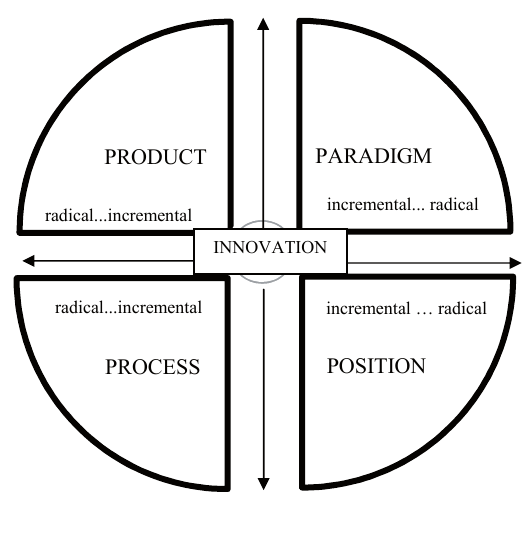
Fig. 2 - Model 4 Ps of innovation (Source: Bessant & Tidd,